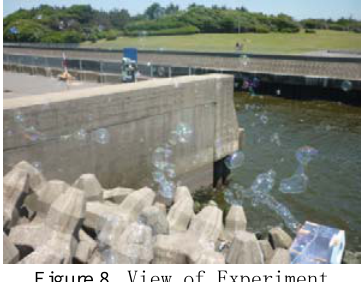
Figure 8. View of Experiment